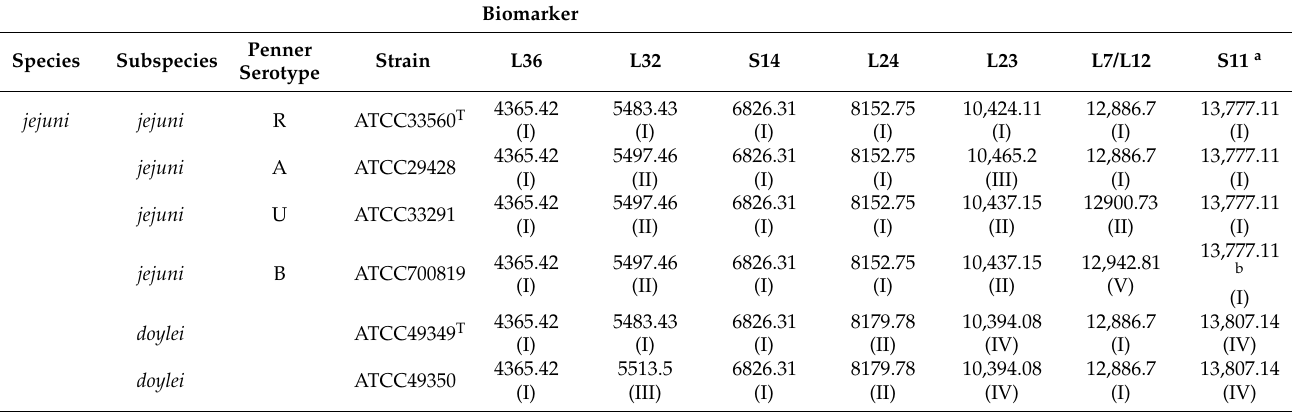
Table 3. Selected biomarkers for proteotyping of Campylobacter spp. in MALDI-TOF MS.